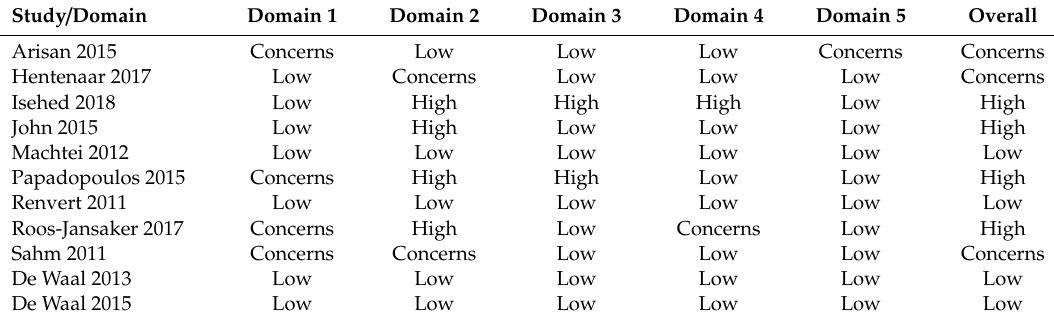
Table 8. Cochrane Risk of Bias